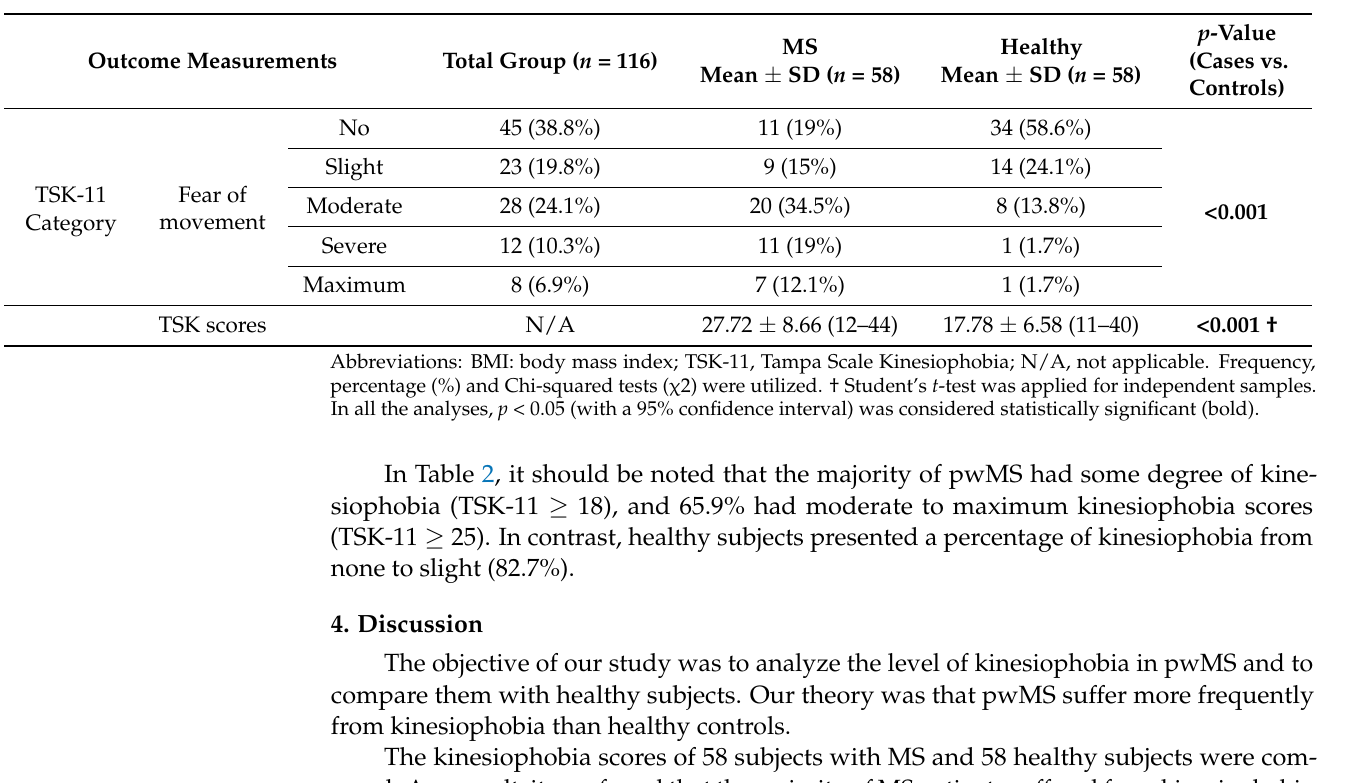
Table 2. Comparisons of TSK-11 scores and categories between pwMS and without